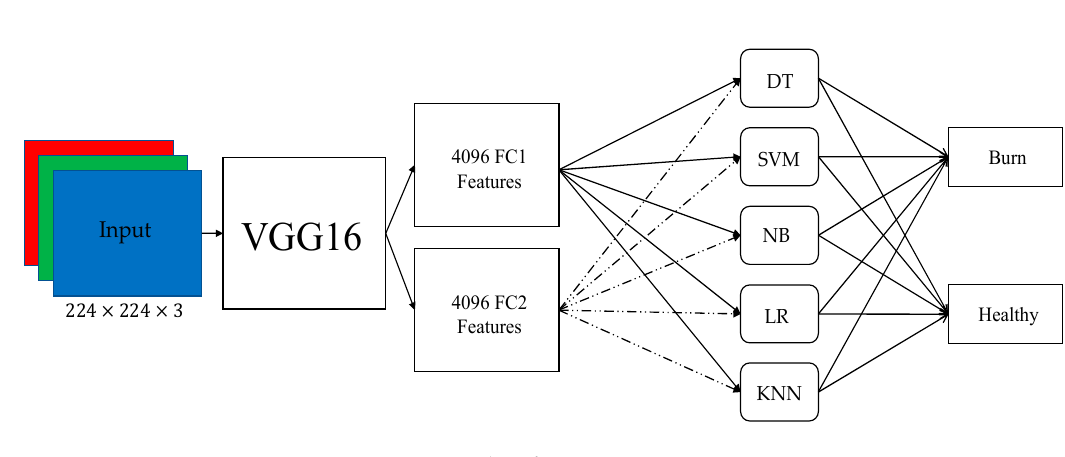
Figure 4. Classification processes.